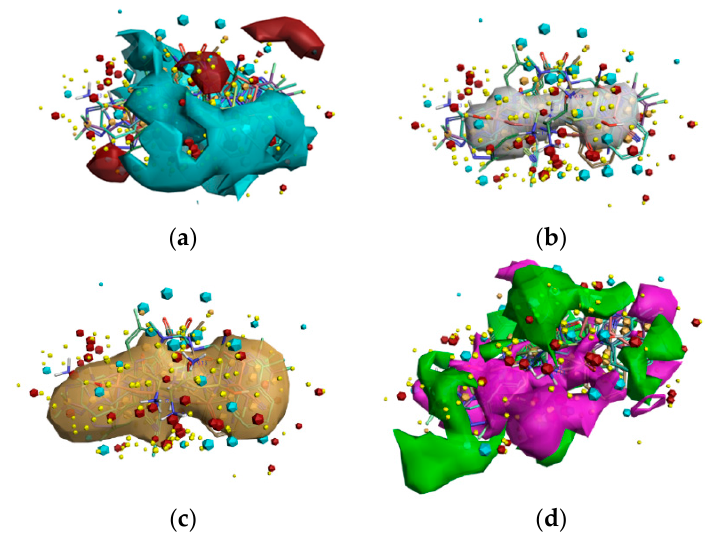
Figure 1. The Activity Atlas model is revealing insights into DPP-4 inhibitory activity. ( a ) Red shows the positive electrostatic field, and blue presents the negative electrostatic field responsible for the inhibition activity of the DPP-4 enzyme. ( b ) White exhibits the average shape responsible for the inhibitory activity. ( c ) Brown designates the hydrophobic shape features for inhibition. ( d ) Inhibition favorable region is shown in green, and unfavorable region shape is shown in purple.